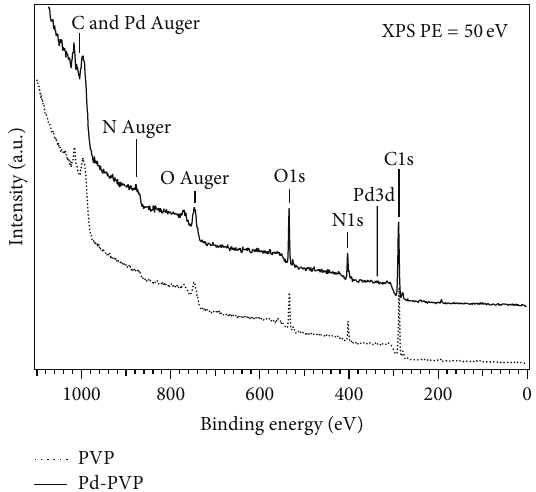
Figure 6: XPS wide-range spectra of Pd nanoparticles in PVP and of a PVP untreated sample for reference.